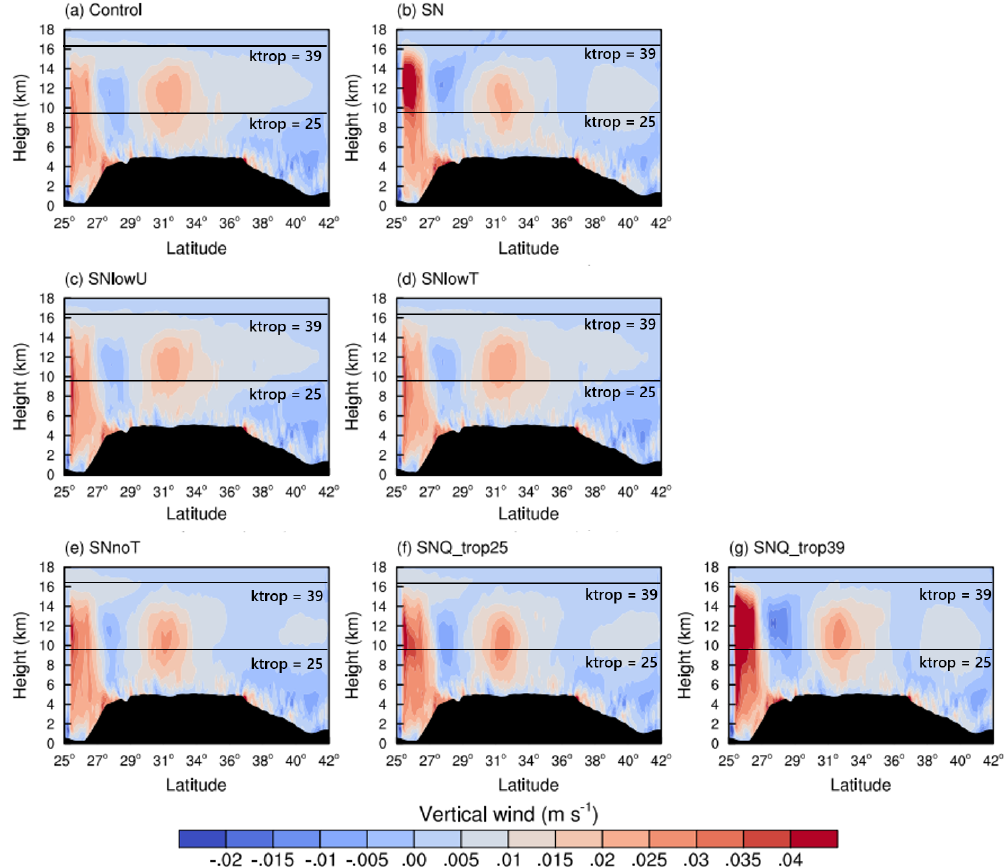
Figure 7. Vertical wind (ms − 1 ; a positive value means upward wind, and a negative value means downward wind) along the average of the 85–95 ◦ E cross section for the following simulations: (a) control, (b) SN, (c) SNlowU, (d) SNlowT, (e) SNnoT, (f) SNQ_trop25, and (g) SNQ_trop39. Solid black lines represent the height of the “ktrop” layers 25 and